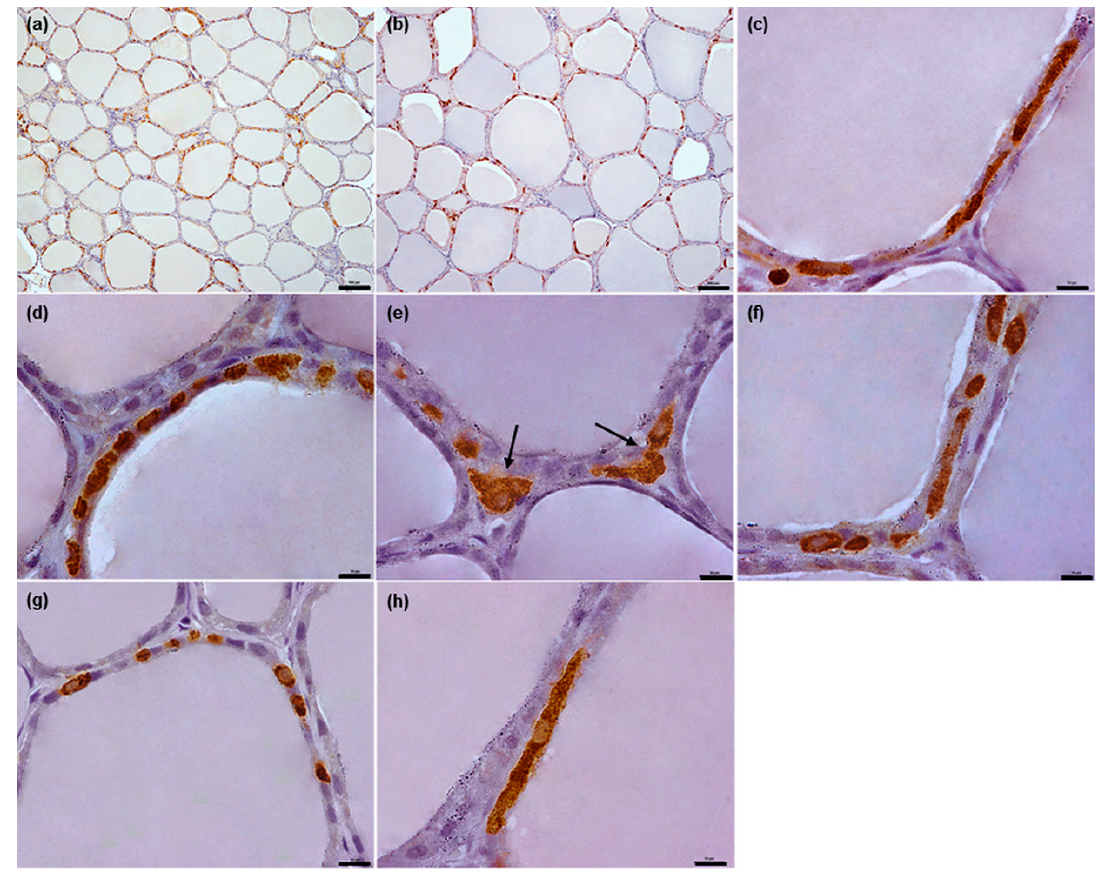
Figure 2. Representative images of porcine C thyrocytes arrangement and morphology. ( a , b ): Typical distribution of C thyrocytes in thyroid parenchyma. ( c – f ): C thyrocyte arrangement within thyroid follicles: “chains” ( c , d ), small groups ( e , arrows), and cells located separately in various orientations in relation to the surface of the thyroid follicle ( f ). ( g , h ): Typical morphology of C thyrocytes in pigs: cells visible in transverse ( g ) and longitudinal ( h ) sections. Immunoperoxidase staining with anti-calcitonin antibody, scale bars: ( a , b ) = 100 µm, ( c – h ) = 10 µm.